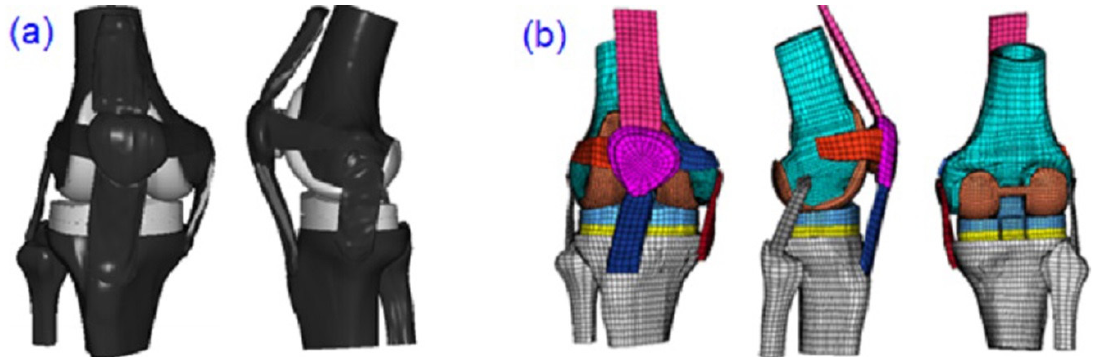
Figure 2. ( a ) 3D geometric anatomical model of knee joint after TKA; ( b ) finite element model of knee joint after TKA.